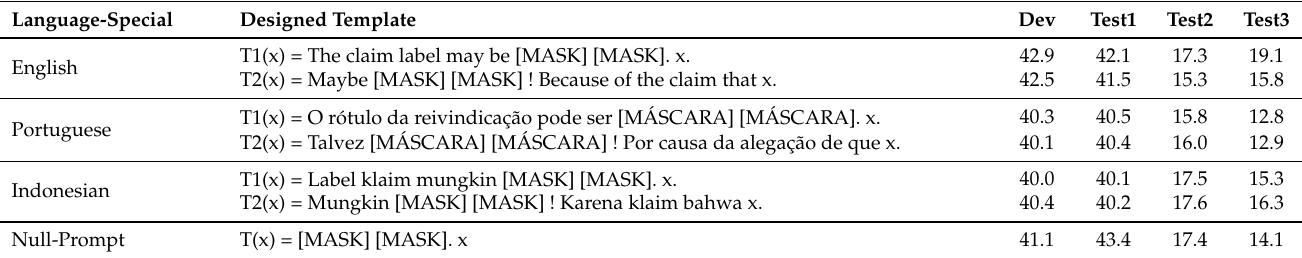
Table 4. The Micro F1 scores evaluated with the different prompt templates encoded by different lan- guages.